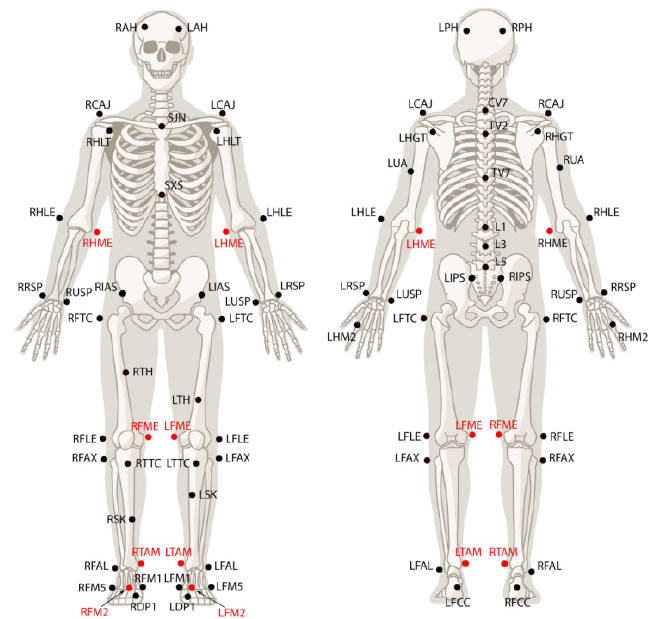
Figure 2. Reflective marker attachment positions. 57 markers were placed on landmarks to build a model predefined by Motive (NaturalPoint Inc., Corvallis, OR, USA).